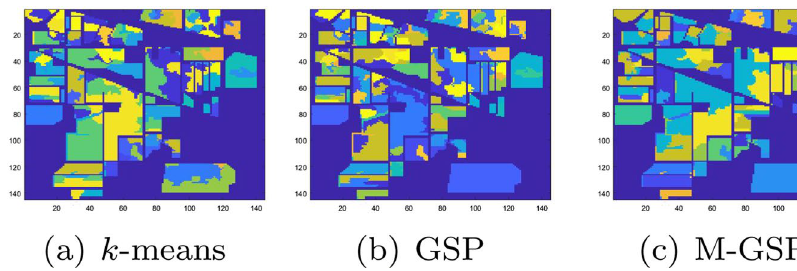
Fig. 10 Segmented results of Indian Pines